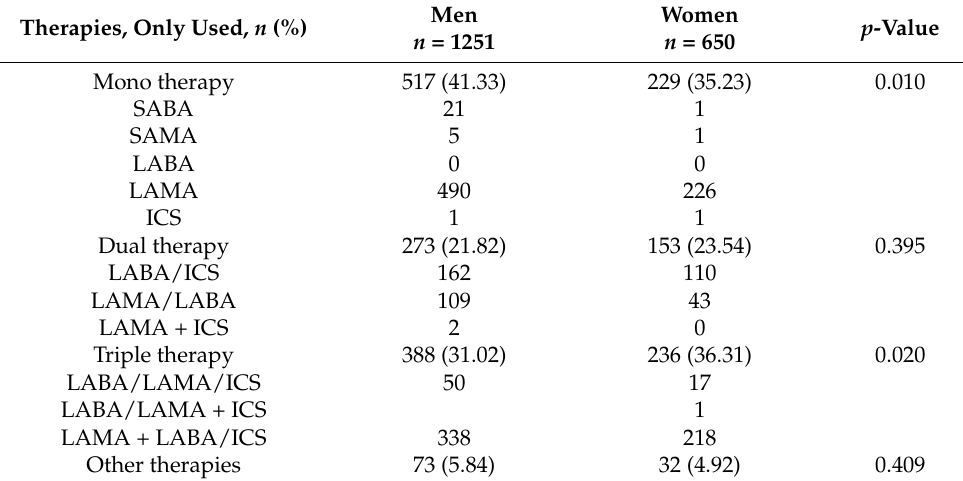
(Table 3). More men had monotherapy, especially LAMA (517 (41.33%) vs. 229 (35.23%), p = 0.010). More women were prescribed triple therapy than males (236 (36.31%) vs. 388 (31.02%), p = 0.020). Table 3. Prescriptions in men and women with COPD. Therapies, Only Used, n